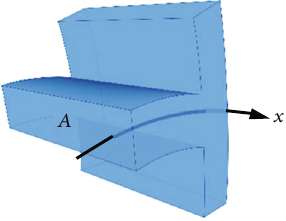
Figure 2: Microstructure of the